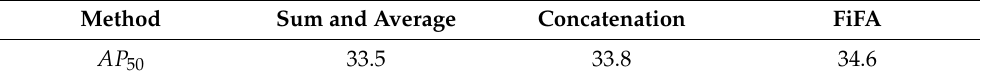
Table 2. Comparison of Average Precision obtained with different fusion strategies on VisDrone2019.